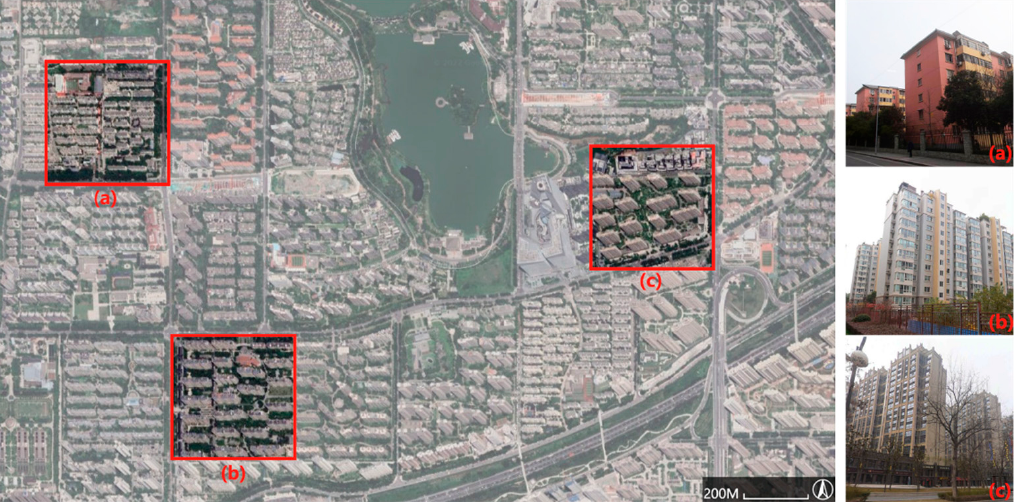
Figure 2. Locations of three selected districts and the photos of main residential buildings (( a ): Low plot ratios district; ( b ): Medium plot ratios district; ( c ): High plot ratios district). Table 1. Basic information of three selected districts.